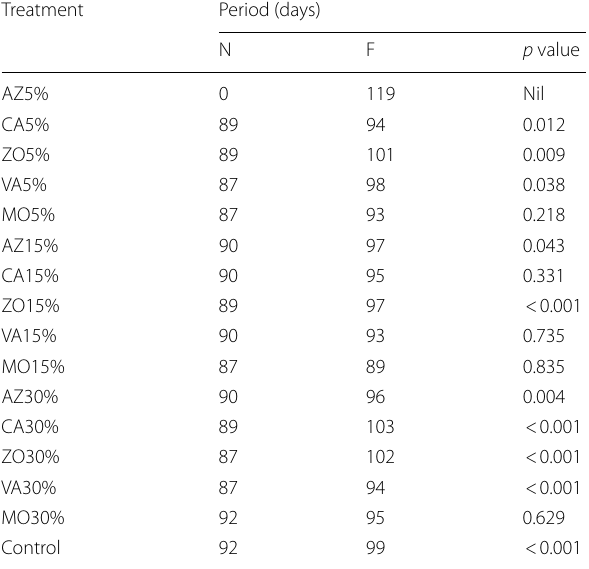
Table 4 Mean number of days to panicle emergence